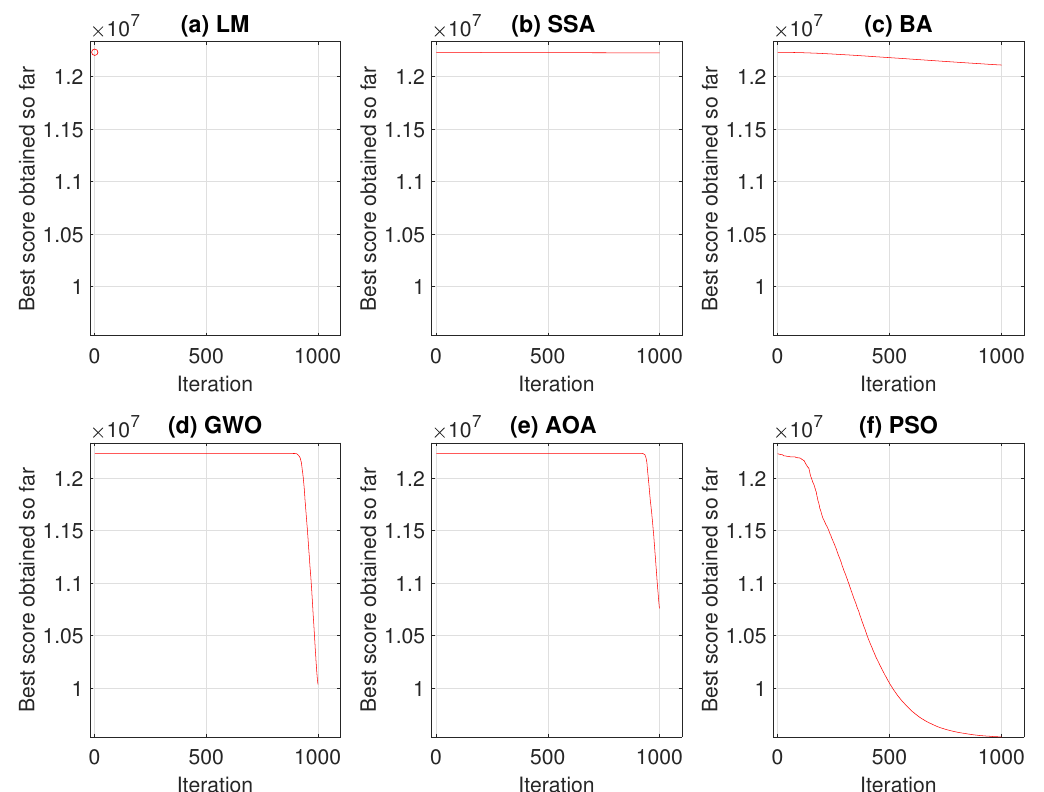
Figure 6. Average Convergence